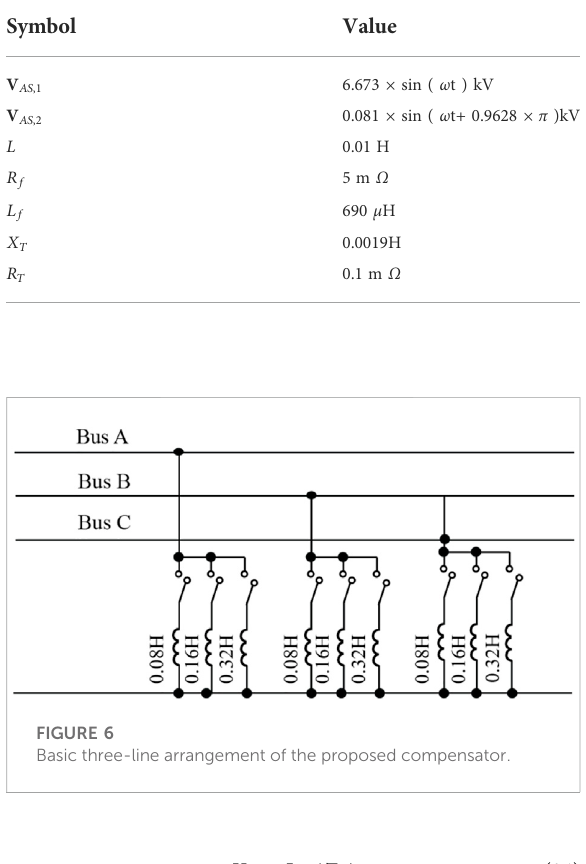
TABLE 1 Parameters of the equivalent circuit of the martabe gold mine.